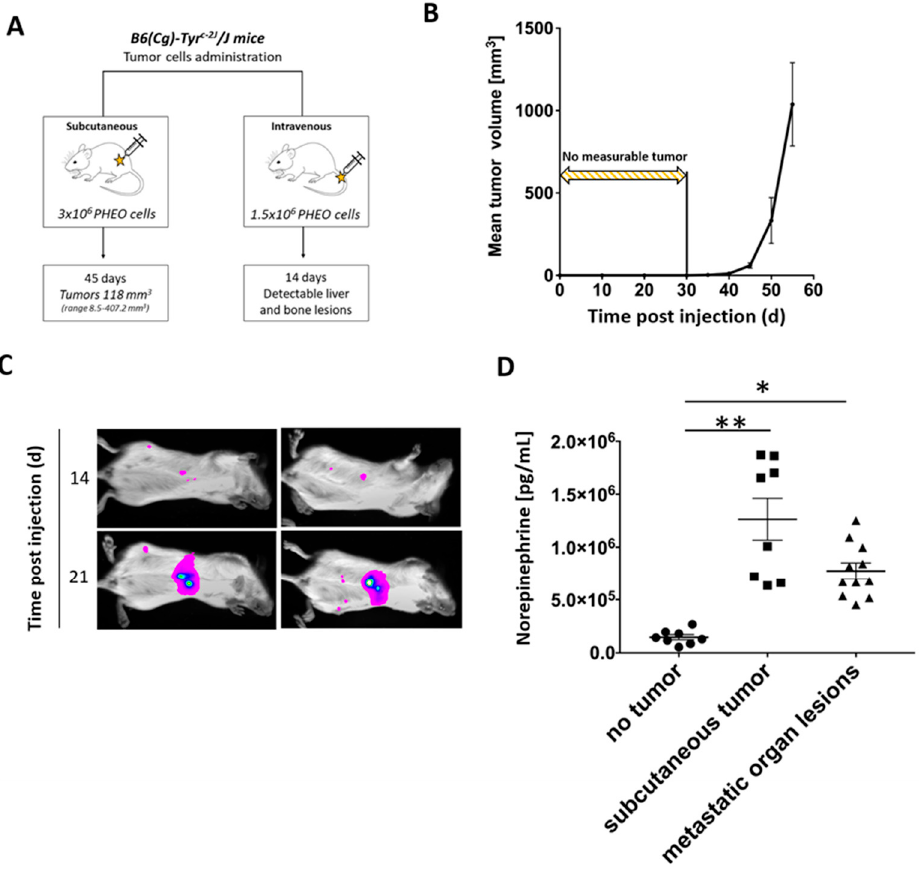
Figure 2. Subcutaneous and metastatic PHEO in mouse model suitable for immunotherapy testing established using MTT-luciferase cells. ( A ) B6(Cg)-Tyr c-2J /J mice were subcutaneously ( n = 24) or intravenously ( n = 10) injected with MTT-luciferase cells. ( B ) Subcutaneous MTT-luciferase tumors reached a mean volume of 118 mm 3 45 days after tumor cell injection. No tumors were detected for 30 days after tumor cells injection. ( C ) Metastatic organ lesions were detectable 14 days after intravenous tumor cells injection using bioluminescence imaging. Metastatic organ lesions were